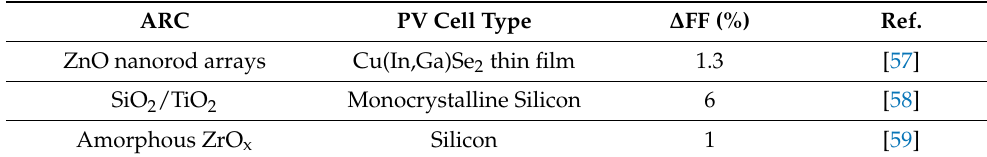
Table 4. Performances of anti-reflective coatings for PV